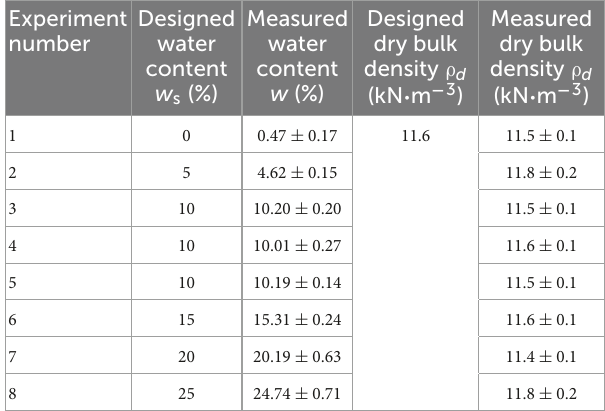
TABLE 3 The experimental